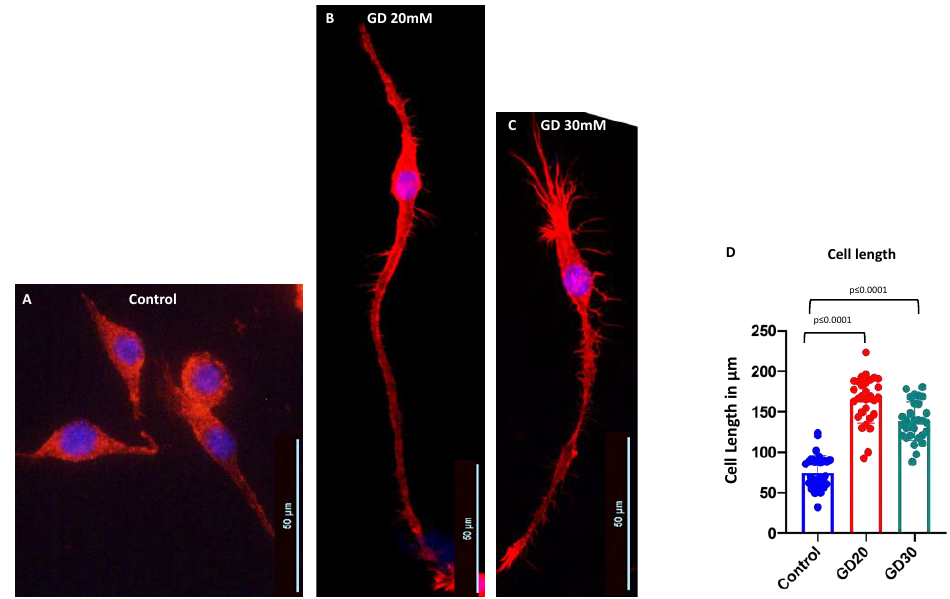
Figure 7. Gadolinium-based MRI contrast Dotarem caused cell elongation. ( A – C ) The images of RAW 264.7 macrophages stained with rhodamine–phalloidin (red) for actin. The nuclei were stained with DAPI (blue). ( A ) Control, untreated cells were slightly elongated. ( B , C ) The cells treated with 20 or 30 mM Dotarem (GD20 and GD30, B , C ) were highly elongated. ( D ) Graph shows that the differences in cell length between the control and the Dotarem (GD)-treated cells calculated from three experiments were statistically highly significant.